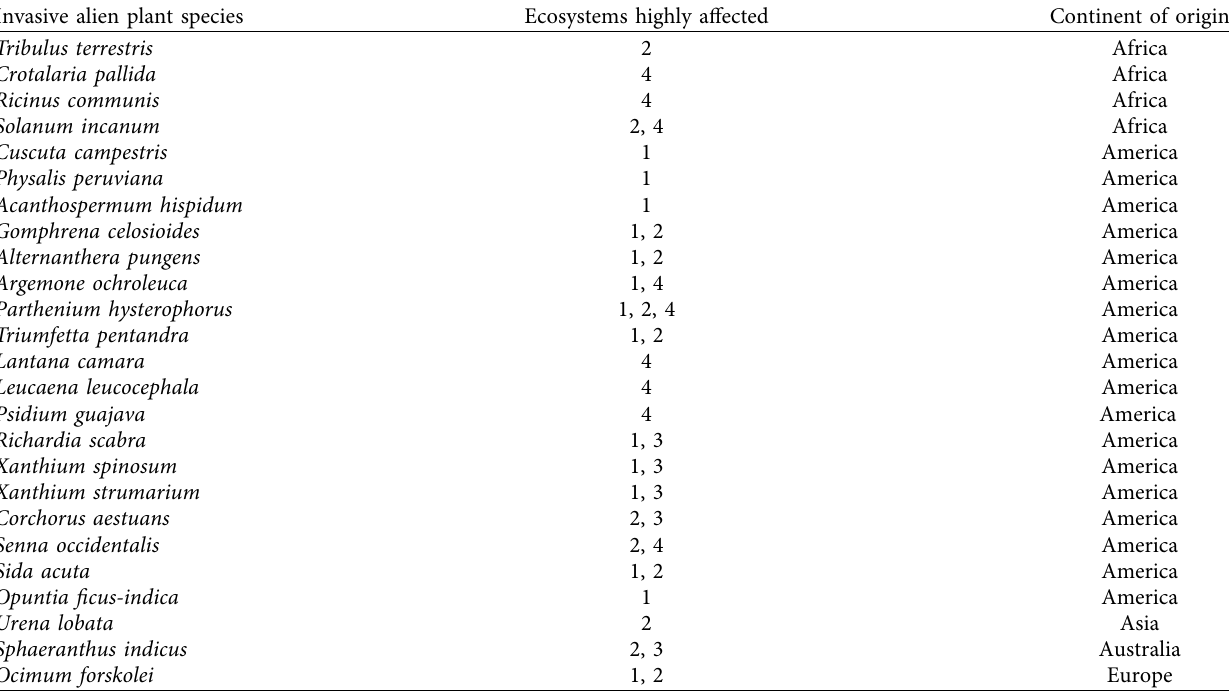
Table 3: Ecosystems affected and continent of origin of invasive alien